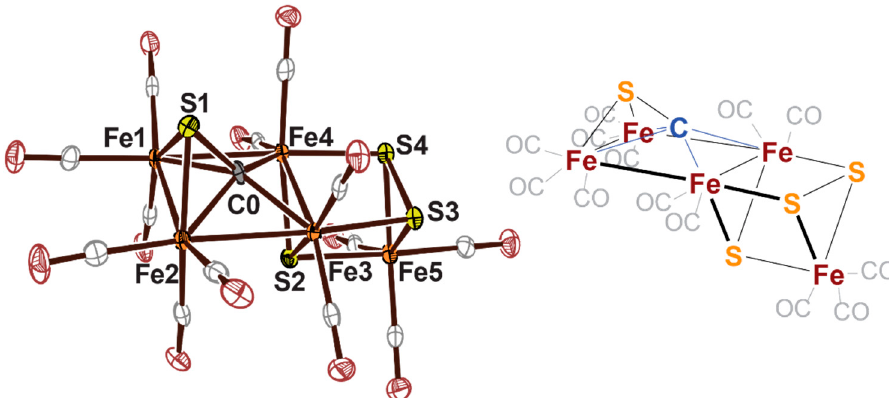
Figure 10. Thermal ellipsoid plots (50% probability) of [{Fe 4 ( κ 2 S– κ 4 C)(CO) 10 }( µ 3 -S)( µ 3 -S 2 )Fe(CO) 3 ] ( 5 ). Orange = Fe, Gray = C, Yellow = S, Maroon = O. Image adapted with permission from Joseph, C., Cobb, C. R., Rose, M. J. Single-Step Insertion of Sulfides and Thiolate into Iron Carbide-Carbonyl Clusters: Unlocking the Synthetic Door to FeMoco Analogues. Angew. Chemie Int. Ed. 2020 , Accepted, not yet published . Copyright Wiley-VCH GmbH . Reproduced with permission.